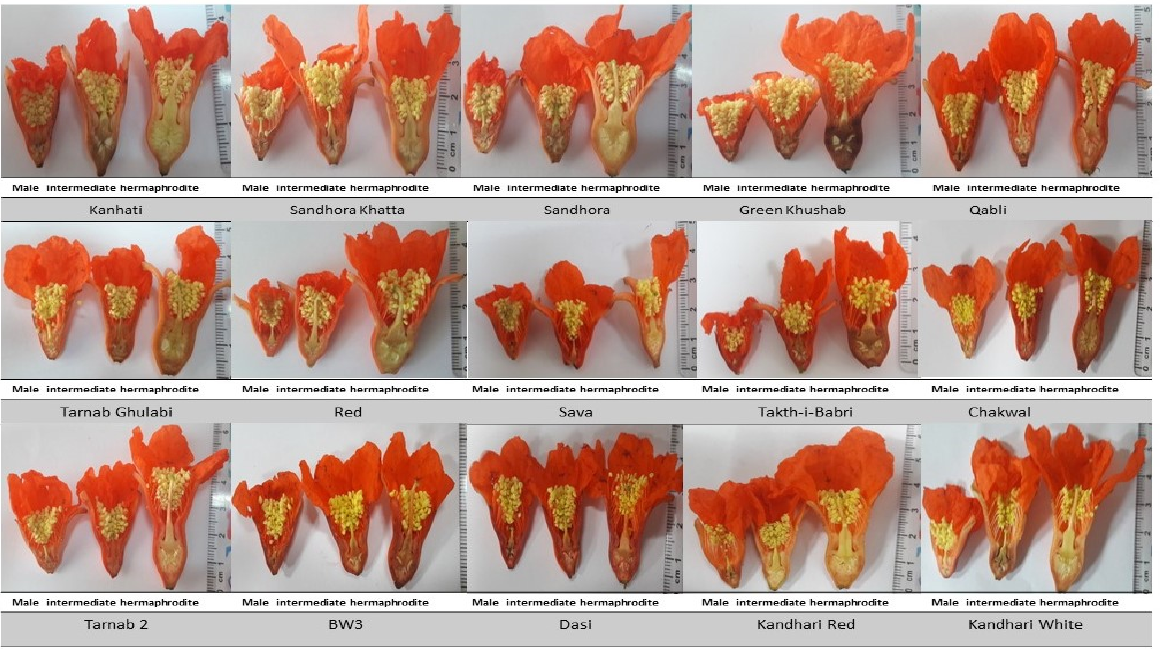
Figure 5. Dissection of three flower types in pomegranate genotypes. Male ( left ) intermediate ( center ) Hermaphrodite ( right ). Table 2. Fruit set percentage among different cross-combinations in pomegranate genotypes (female × male).